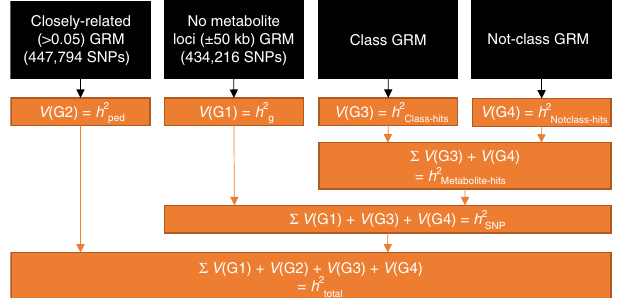
Fig. 1 Overview of the four-variance component models. Overview of the SNP- fi ltering and GRM construction can be found in Supplementary Fig. 1 and is explained in details in the Methods. This fi gure describes which GRMs (black boxes) are used to calculate which variance components (orange boxes) by drawing black arrows from the GRMs to the variance components. The variance components give rise to the four different heritability estimates: h 2 ped , h 2 g , h 2 Class-hits , and h 2 Notclass-hits (see Methods). The orange arrows indicate how the various variance components are summed to obtain estimates for h 2 metabolite-hits , h 2 SNP , and h 2 total (see